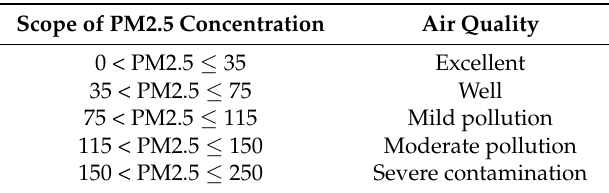
Table 4. The grades of air